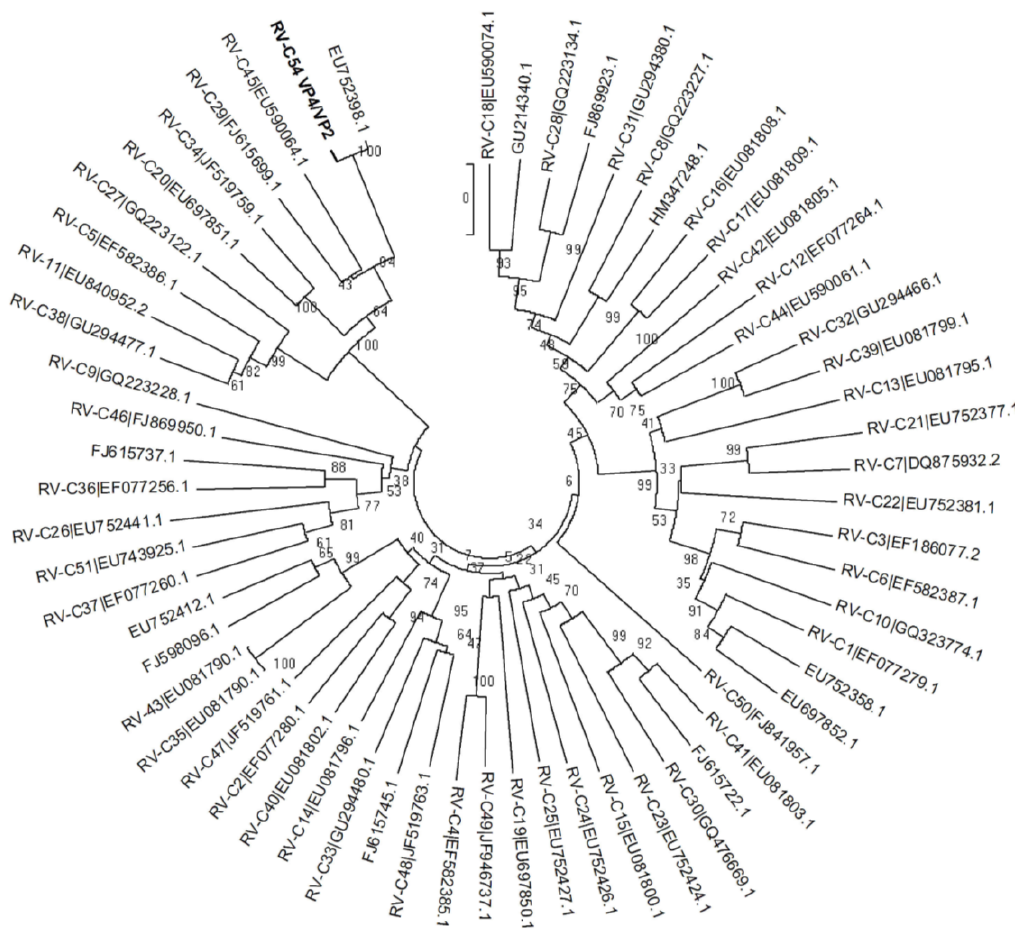
Figure 3. Phylogenetic tree based on nucleotide sequence of the VP4/VP2 gene. The neighbor-joining tree (Maximum Composite Likelihood model) was evaluated by 1000 bootstrap pseudo-replicates. RV-C54 is indicated in bold. Sequences of strains awaiting complete genome or VP1 sequencing, and thus their final type assignment, are indicated with GenBank accession numbers only.